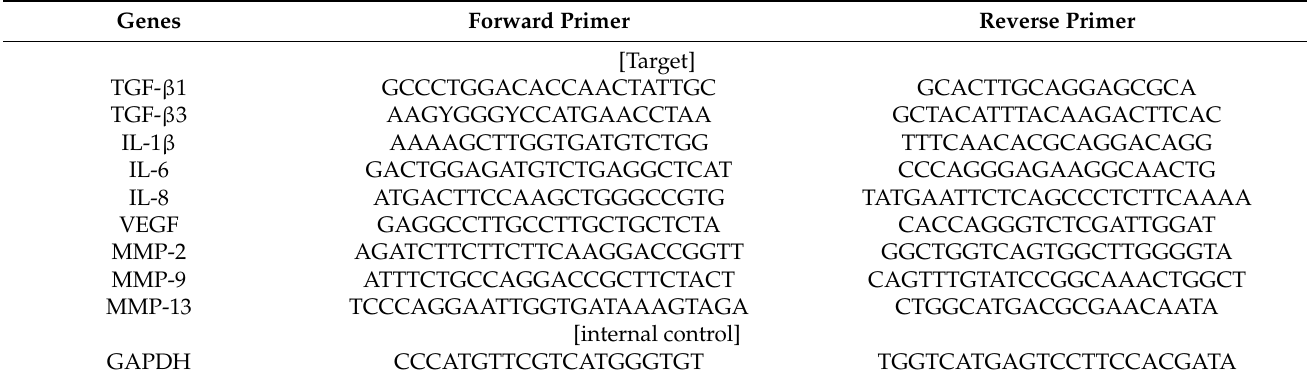
Table 4. Primer sequences used for realtime-PCR